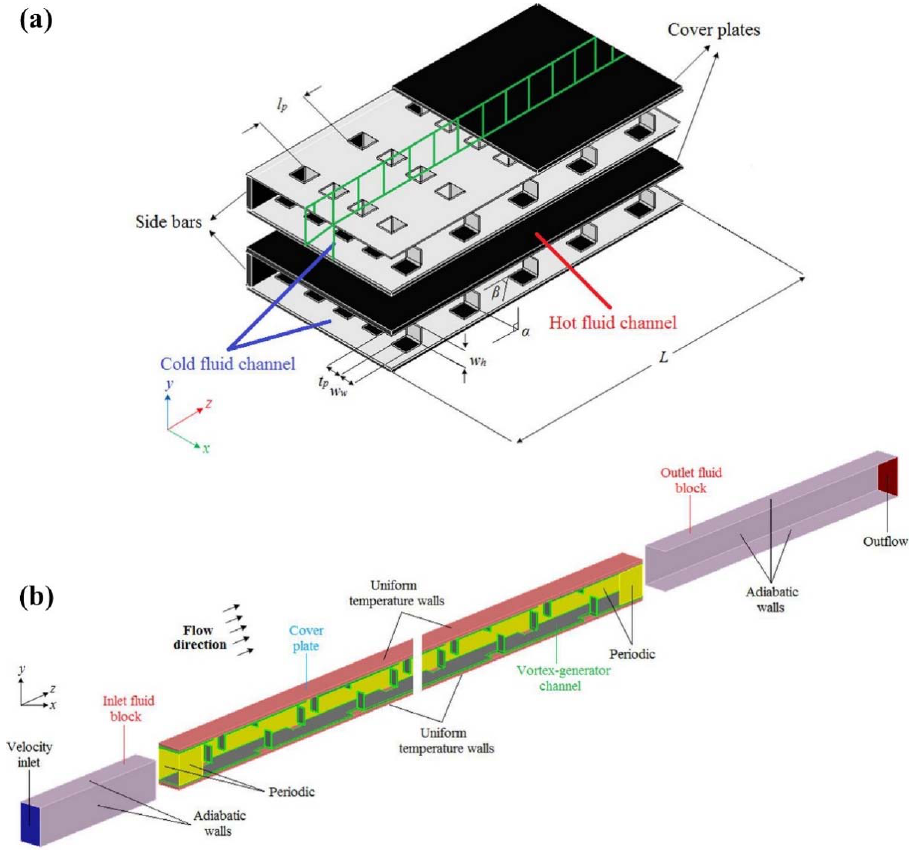
Figure 16. A schematic view of the: ( a ) studied plate-fin heat exchanger equipped with vortex-generator, and ( b ) the computation domain. Reproduced with permission from [204]. Elsevier, 2014.